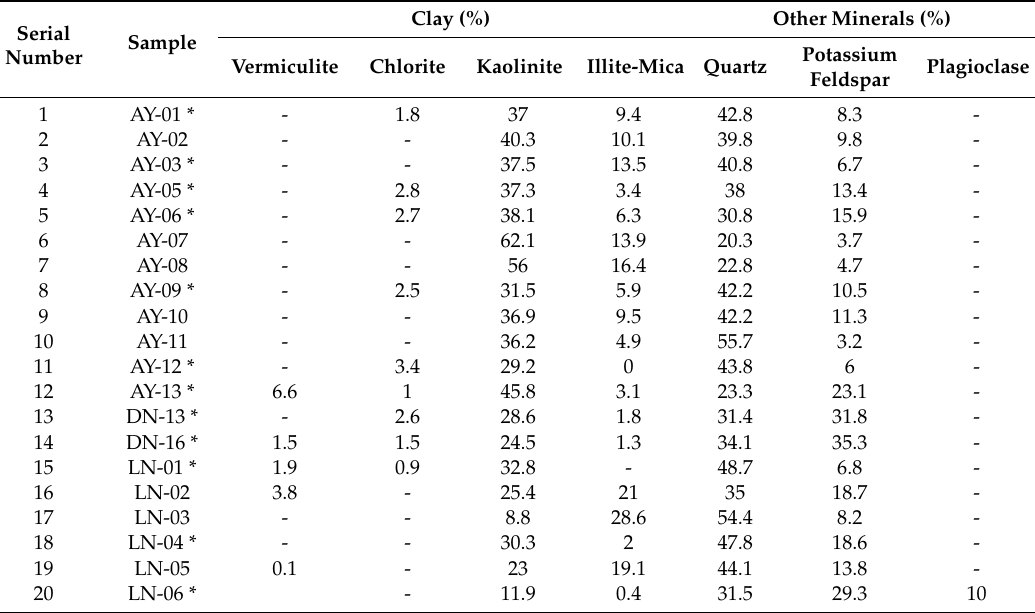
Table 2. Main clay minerals content of regional in